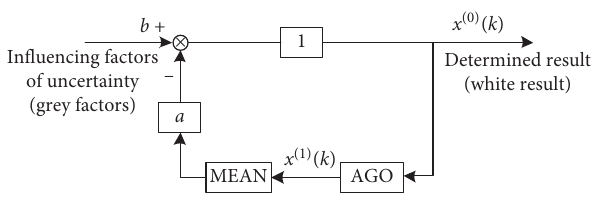
Figure 1: The network model diagram of GM(1,1)